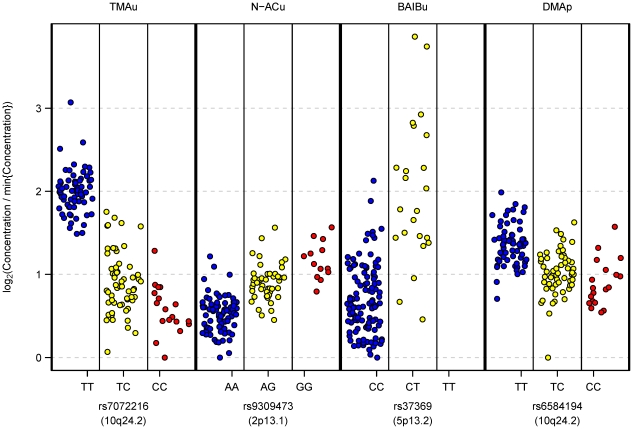
Relative metabolite concentrations against genotypes at their most significantly associated mQTL SNP.Each point corresponds to a study participant's mQTL genotype and corresponding metabolite concentration. Metabolite identifiers are labelled at top. Genotypic classes for each mQTL are shown on the horizontal axis (random horizontal variation within each genotypic class is introduced for clarity); dbSNP identifiers are labelled at bottom. At each metabolite peak, the transformed data vector shown in the plot is , where denotes the vector of normalized peak heights at that peak (prior to any logarithmic transformation, as described in 
Materials and Methods
). So, the transformation maps to zero the lowest observed concentration of each metabolite, and log2(fold change) can be visually quantified relative to this baseline level. In particular, the maximum observed log2(fold change) in a metabolite's concentration is easily accessible from the plot. Within-participant replicate observations (biological and technical) were averaged on log2 scale.